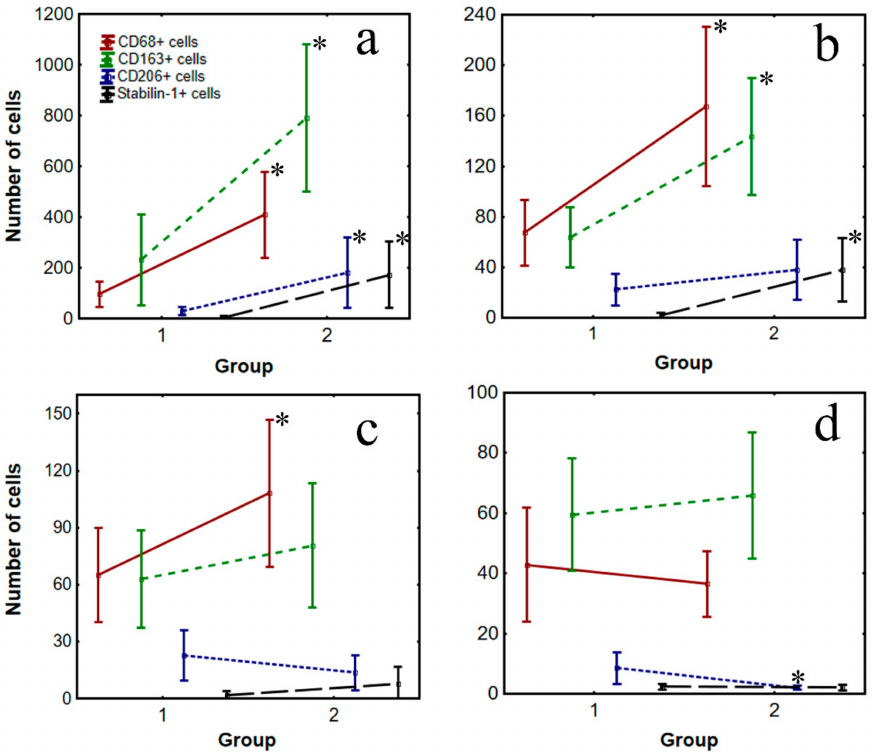
Figure 2. Dynamics of cardiac and kidney macrophages in patients (n = 30) with fatal MI. Note: a —infarct area of myocardium, b —peri-infarct area of myocardium, c —non-infarct of myocardium, d —kidney. ∗ —statistically significant between the groups. The spatio-temporal correlation between kidney and cardiac macrophages was then assessed (Figure 3).